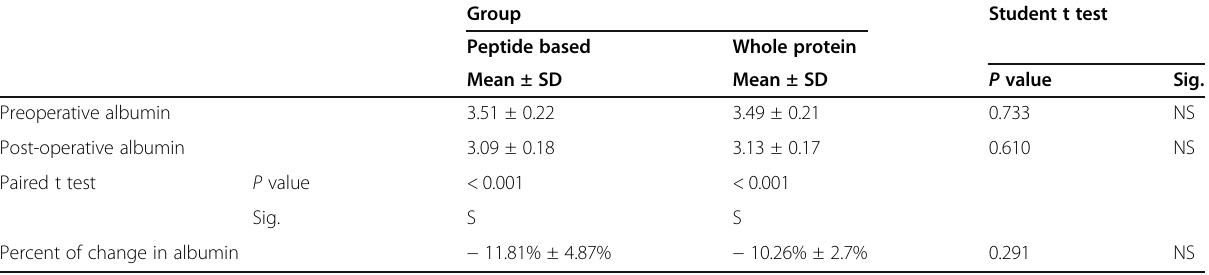
Table 1 Pre- and postoperative albumin